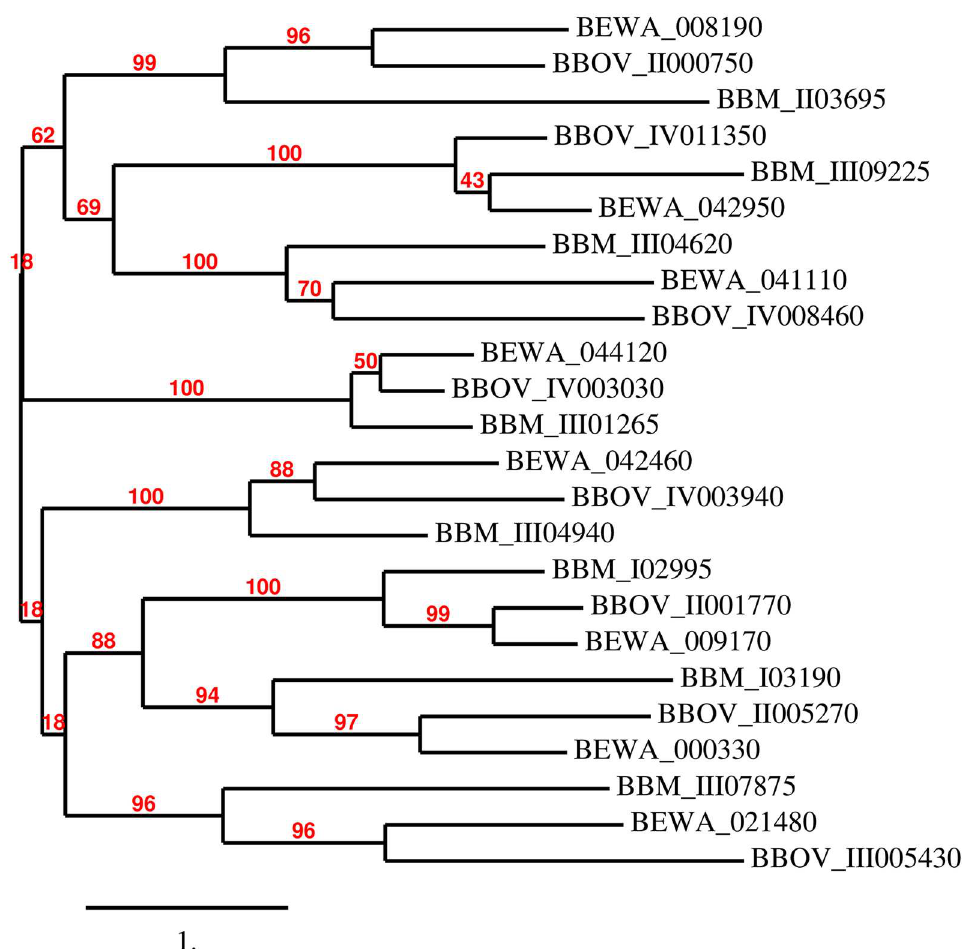
in B . bovis , B . microti , and T . equi with the program phylogeny.fr. The program calculated the branch support values in percent (%, red font) using an aLRT statistical test